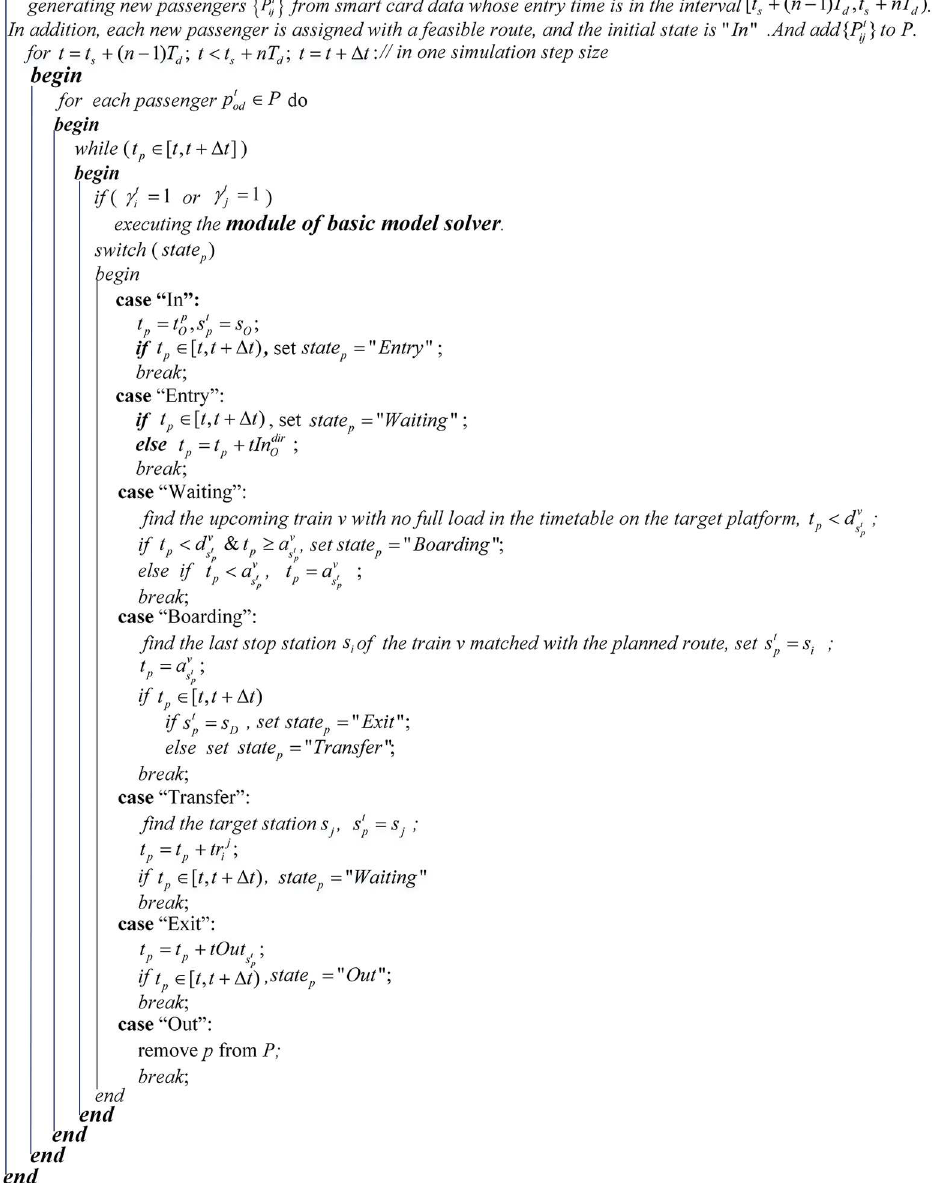
Fig 5. The passenger simulator module. The parameters are initializedfirstly. And then the in each simulationstep of each simulationperiod, each passengerwill get the most out of what they can do. One passenger’s singlerail journeywill start from the enteringa station, and ends up with exitinga station. The wholeprocess will be tracked by the transitionsof passengerstates, namely “In”, “Entry”, “Waiting”, “Transfer”, “Boarding”, “Alighting”, “Exit”, or